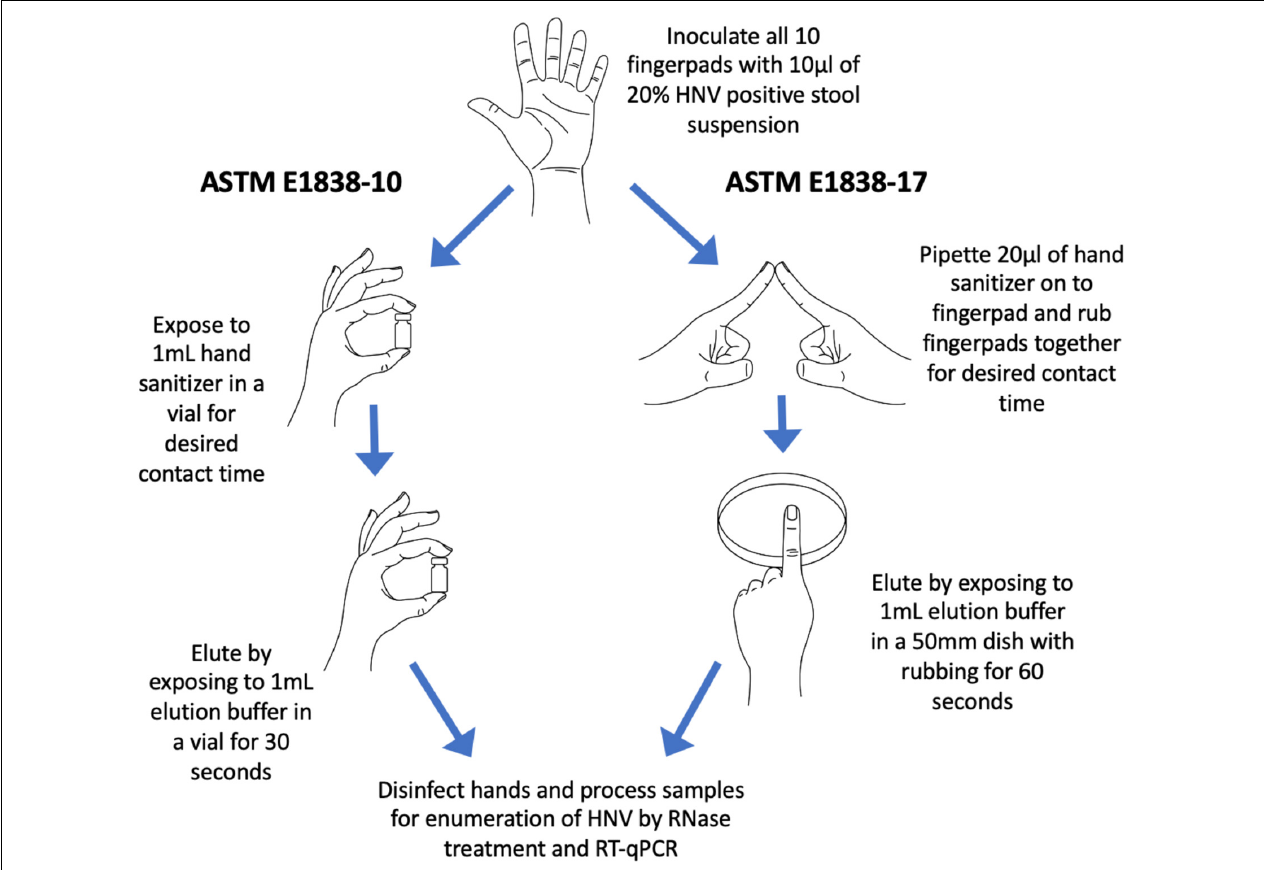
FIGURE 1 | Diagram of the 2010 ASTM E1838-10 fingerpad method and the newer 2017 ASTM E1838-17 method. The two major differences between the methods are (1) ASTM E1838-10 does not include a rubbing step; and (2) virus elution is done by up-and-down inversions of buffer in a vial for ASTM E1838-10, and by rubbing fingerpads in a petri dish containing buffer for ASTM